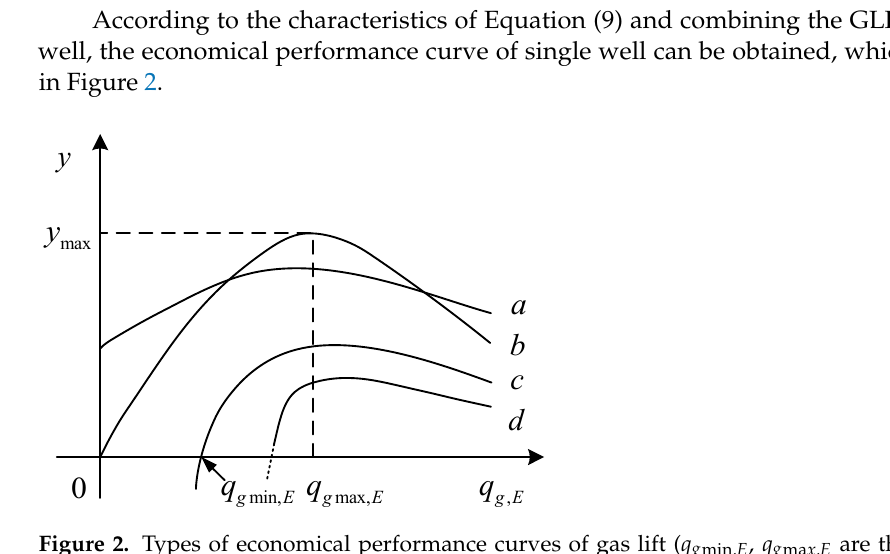
Figure 2. Types of economical performance curves of gas lift ( q g min ,E , q g ma x,E are the minimum, maximum injected gas rate; abc and d represent four different gas lift economical performance curves).